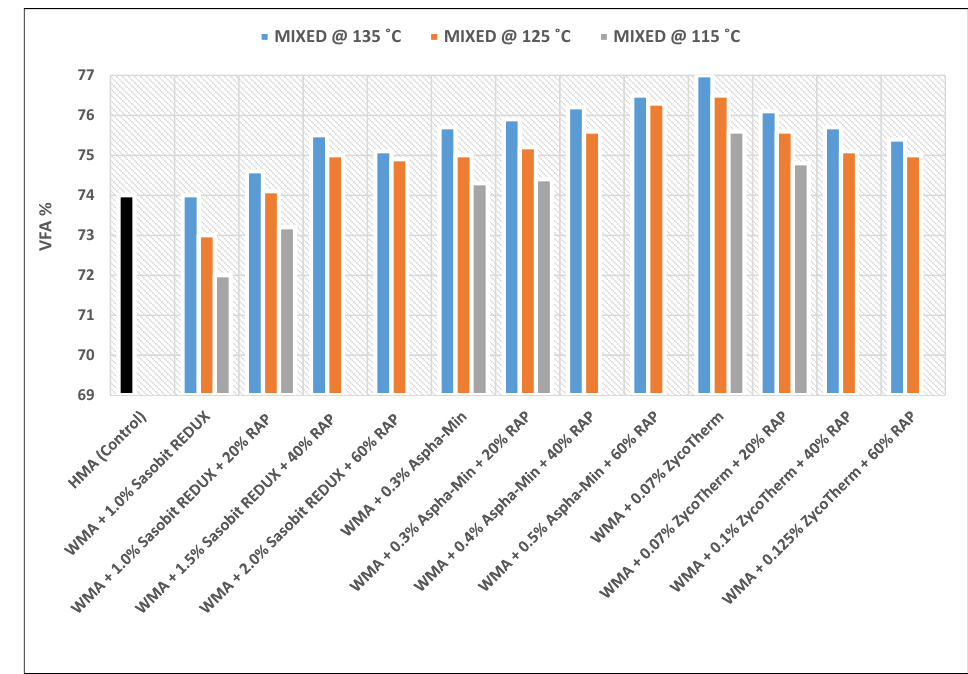
Figure 18. VFA% for the modified virgin and recycled WMA mixtures.